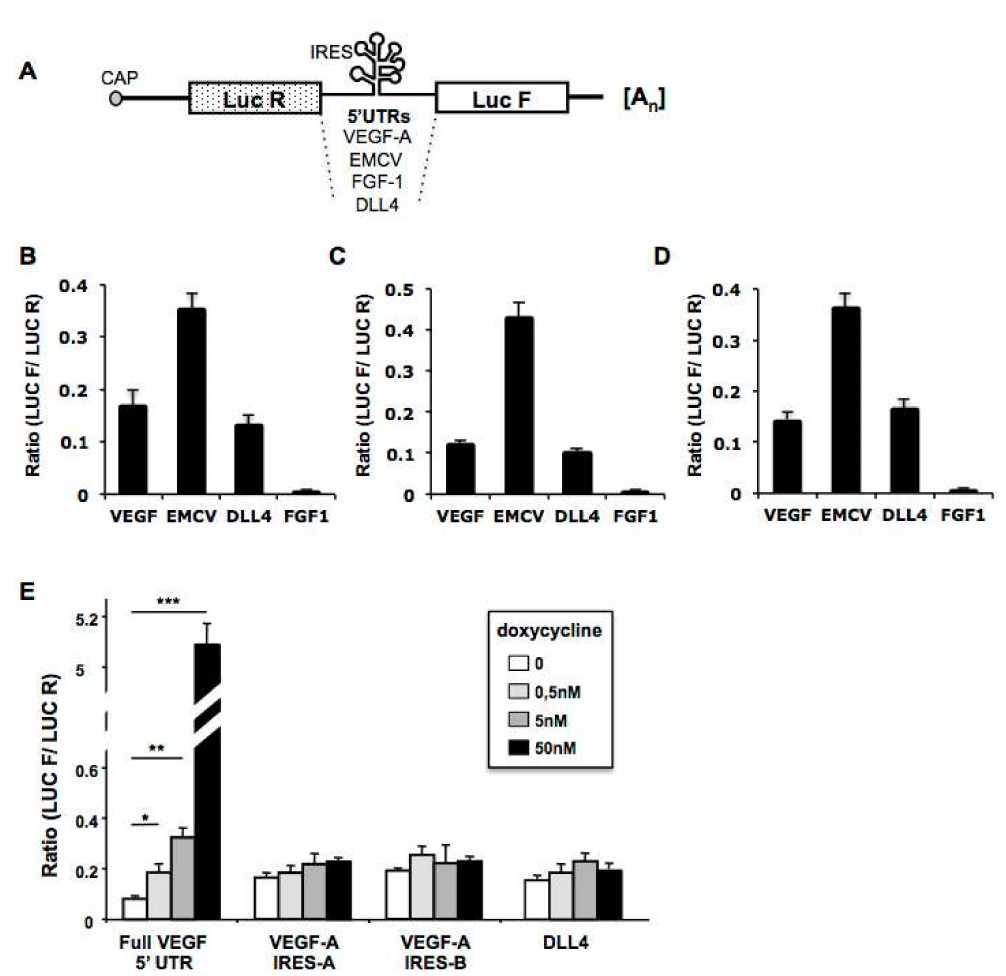
Figure 1. DLL4 5 (cid:48) -UTR contains an internal ribosome entry site. ( A ) Schematic representation of bicistronic constructs. IRESs cloned within the inter-cistronic region were either viral ( EMCV ) or cellular ( VEGF-A IRESA, VEGF-A IRESB, FGF-1 , DLL4 ), ( B – D ) Analysis of the DLL4 IRES activity in transiently transfected ( B ) HeLa, ( C ) HUVEC or ( D ) NIH3T3 cells. 48h after transfection IRES activity was determined by calculating the LucF/LucR ratio. DLL4 IRES activity was compared to that of the cellular IRES-A of VEGF-A , the viral EMCV IRES or the FGF-1A IRES, known to be highly tissue and cell line specific. ( E ) HeLa Tet off cells were transfected with TET sensitive bicistronic constructs containing the full 5 (cid:48) -untranslated region of DLL4 . At 2 h prior to transfection, cells were treated with 0.5 nM, 5 nM or 50 nM doxycycline (Dox). Forty-eight hours after transfection, luciferase activities were measured as described. As positive controls, the VEGF-A full 5 (cid:48) -UTR (containing a cryptic promoter) was introduced in the intercistronic region and only the VEGF-A IRES A or B as negative controls (sequences without cryptic promoter). Data are means ± SEM from 3 independent experiments in duplicates, * p < 0.05, ** p < 0.01, *** p <